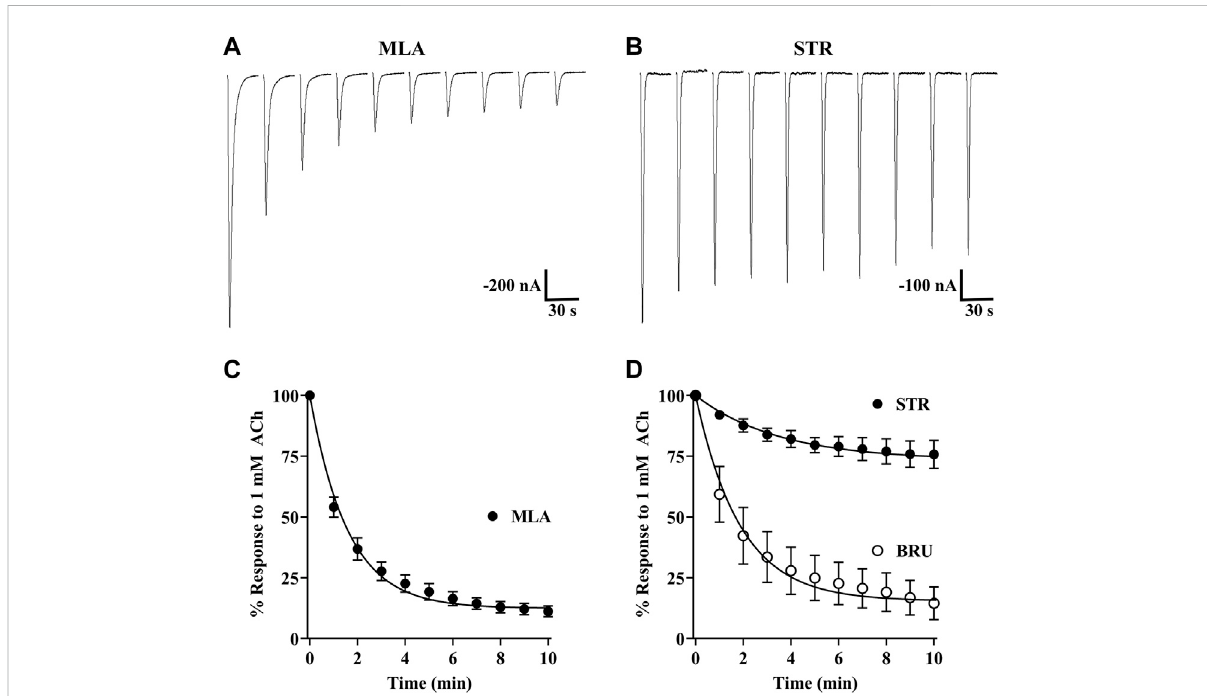
FIGURE 3 Strychnine, BRU, and MLA produce differential effects on α 10 nAChR functionality. X. laevis oocytes were injected with cRNA encoding human α 10 subunits and treated for 3 days in frog saline containing MLA (20 μ M), STR (20 μ M), or BRU (20 μ M) and assessed by voltage-clamp electrophysiology. (A) CurrenttracesfromanoocytetreatedwithMLAandstimulatedwithacetylcholine(ACh;1 mM)immediatelyafterbeingplaced in the recording chamber. (B) Current traces from an oocyte treated with STR and stimulated with ACh immediately after being placed in the recording chamber. (C) The calculated plateau values indicated that currents from oocytes treated with MLA would decay to 12 (11 – 13) % (n = 8) of initial current amplitudes. (D) Similarly, currents from oocytes treated with BRU would decay to 15 (13 – 17) % (n = 8) of initial values. By contrast, oocytes treated with STR decayed to only 74 (72 – 76) % (n = 13) of initial values. Representative current traces for MLA and STR are shown with the 30 sinterpulseintervalsreducedto5 sforbrevity.Theerrorbarsin (C) and (D) indicateSDandvaluesinparenthesisindicate95%CI.The “ n ” indicates the number of oocytes obtained from fi ve